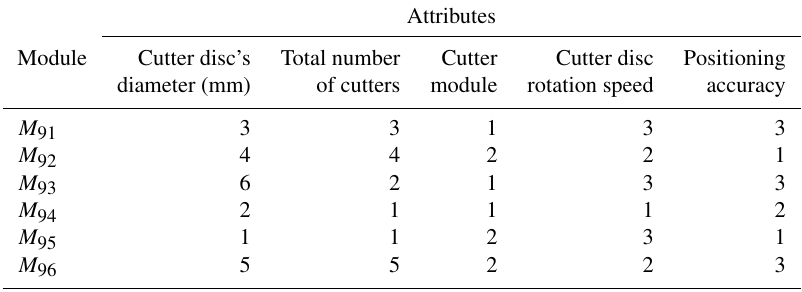
Table 7. Priority of the cutter disc module attributes.